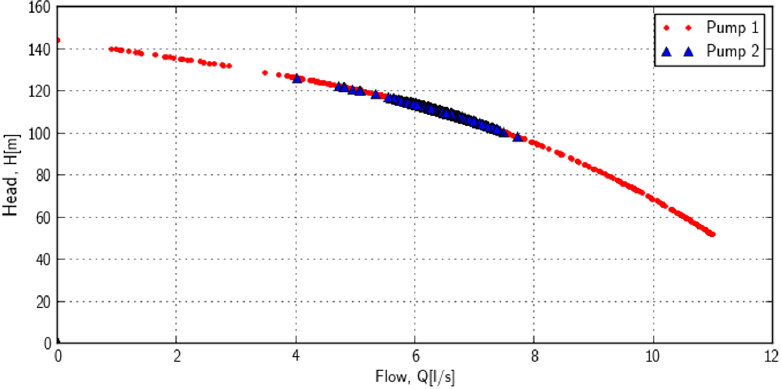
Figure 10. The operating point positions on the PU1 and PU2 H(Q) characteristics in December 2009 .